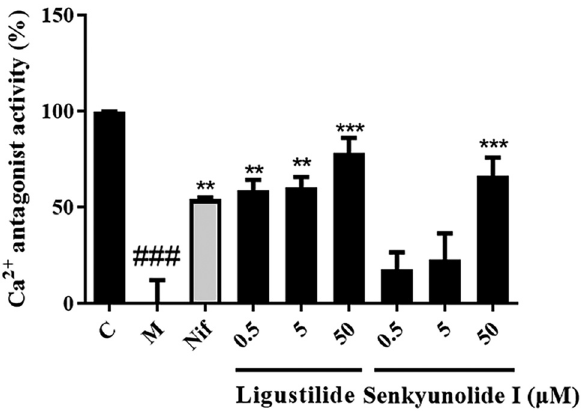
Figure 4: Dual - luciferase reporter assay to study the calcium antagonistic e ff ect of di ff erent concentrations of Lig and S I. Data are shown as the mean ± SD; n = 5 per group. ### P < 0.001 compared with the control group; ** P < 0.01, *** P < 0.001 compared to the model group; C, control; M, model